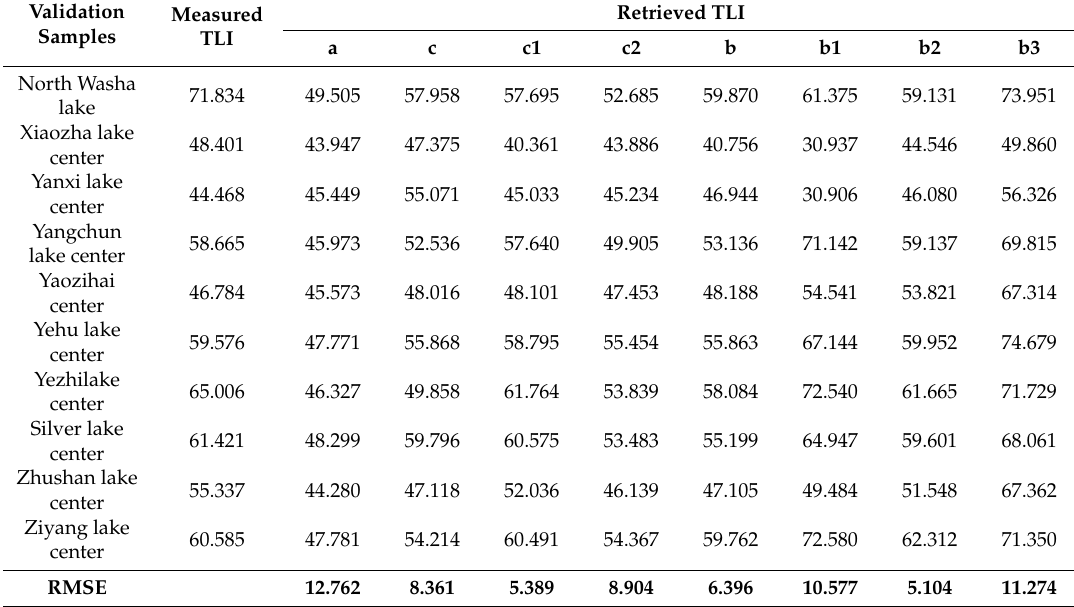
Table 6. Validation errors of eight